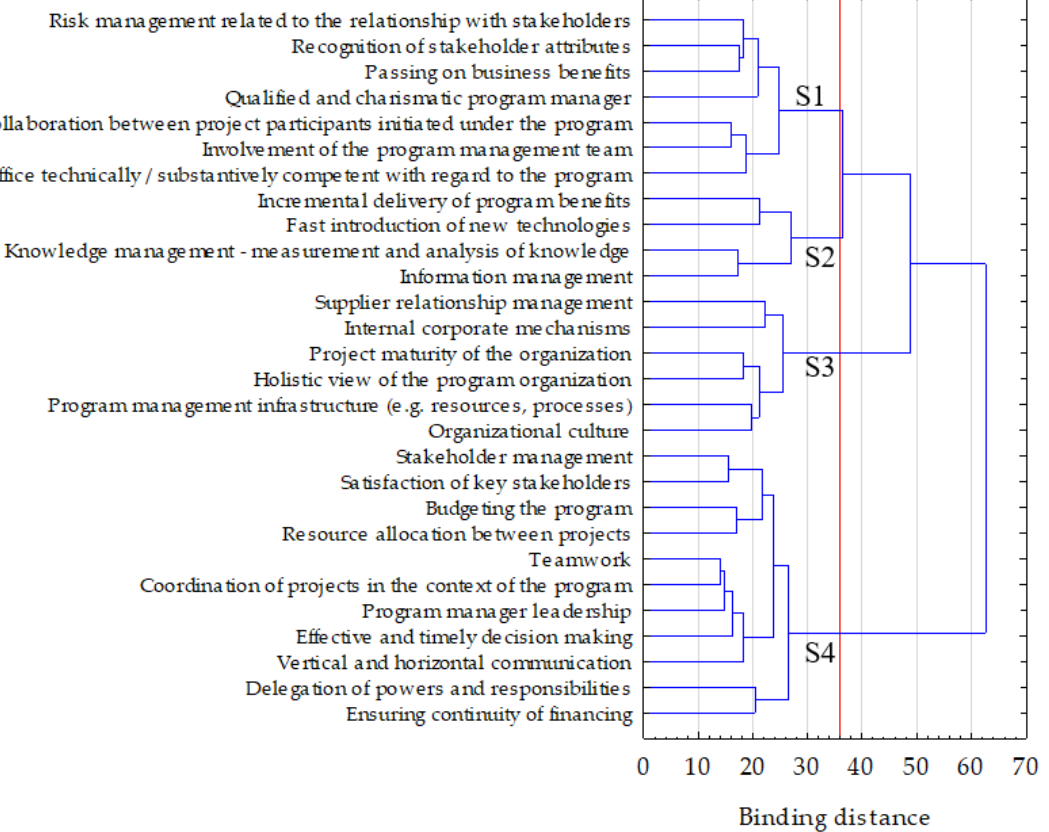
Figure 3. A detailed distribution of the variables classified into individual clusters.